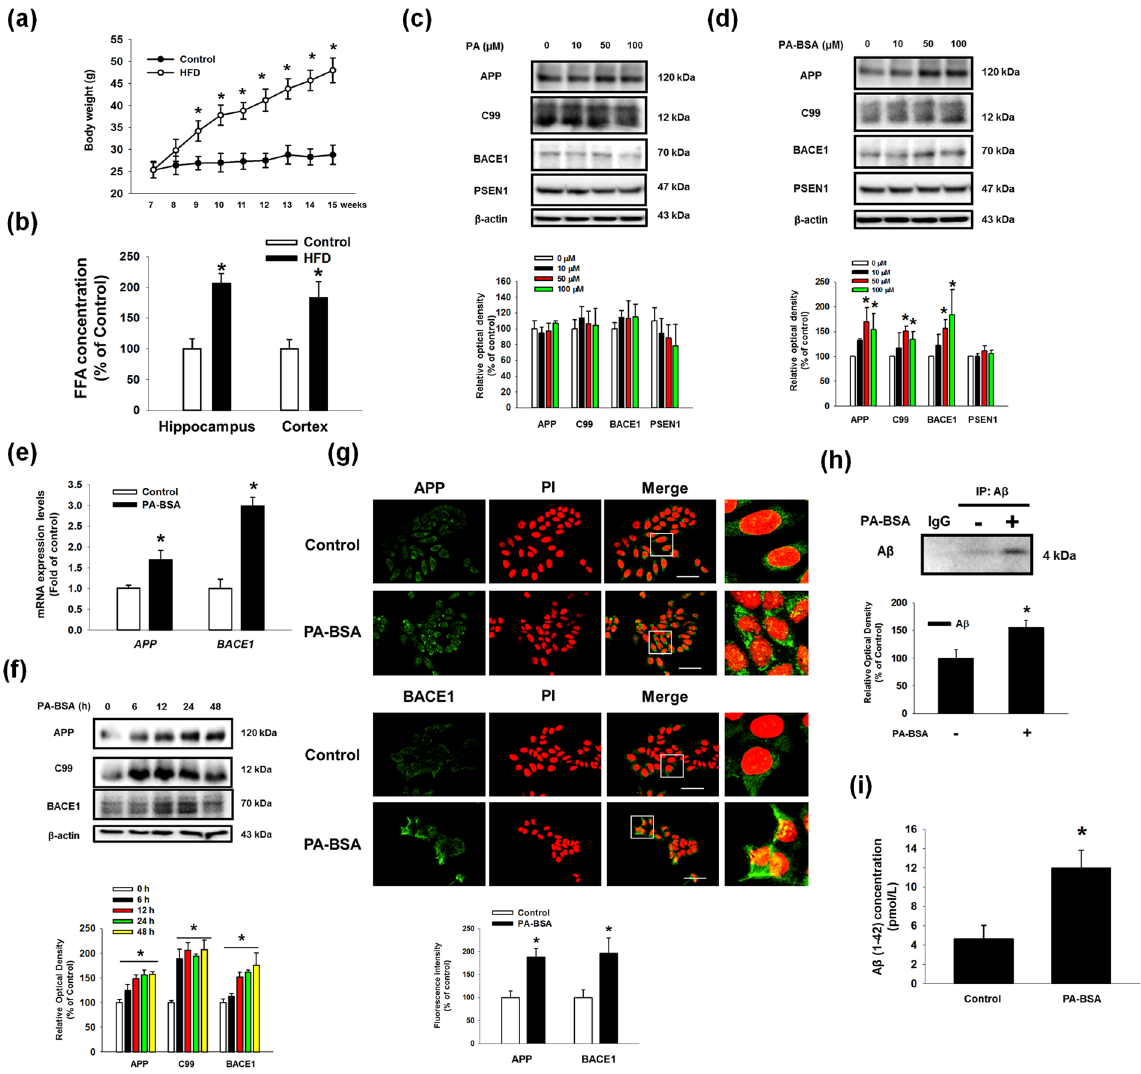
Figure 2. Effect of PA-BSA on the regulation of APP and BACE1 expressions and A β production in SK-N-MC cells. ( a ) The body weights of mice fed regular chow diet as a control or a HFD every week for 8 weeks. ( b ) Total FA concentration level in mouse brain samples was measured by using commercial kit described in Materials & Methods. Data are presented as a mean ± S.E.M. n = 5 . ( c ) SK-N-MC cells were incubated with various concentrations of PA (0–100 μ M) for 24 h. APP, C99, BACE1, PSEN1 and β -actin proteins were assessed with western blot. n = 4 . ( d ) SK-N-MC cells were incubated with various concentrations of PA-BSA (0–100 μ M) for 24 h. APP, C99, BACE1, PSEN1 and β -actin proteins were assessed with western blot. n = 4 . ( e ) SK-N-MCs were incubated with 50 μ M of PA-BSA for 24 h. mRNA expressions of APP and BACE1 were analyzed by quantitative real time PCR. Data were normalized by GAPDH mRNA expression level. Data are reported as a mean ± S.E.M. n = 4 . ( f ) SK-N-MC cells were treated with PA-BSA for 0–48 h. The expressions of APP, C99, BACE1, PSEN1 and β -actin were analyzed by western blot. n = 4 . ( g ) SK-N-MC cells were immunostained with APP and BACE1 antibodies and PI. Fluorescence images shown are representative. All scale bars, 50 μ m (magnification, × 600). Fluorescence intensity data of APP and BACE1 is presented as a mean ± S.E.M. n = 5 . ( h ) Cells were incubated with 50 μ M of PA-BSA for 72 h. Secreted A β in medium was analyzed by immunoprecipitation assay. Data are presented as a mean ± S.E.M. n = 3 . ( i ) Cells were incubated with 50 μ M of PA-BSA for 48 h. A β concentration of medium samples were detected by using ELISA kit. Data are presented as a mean ± S.E.M. n = 6 . Each blot result shown is representative image. * p < 0.05 versus